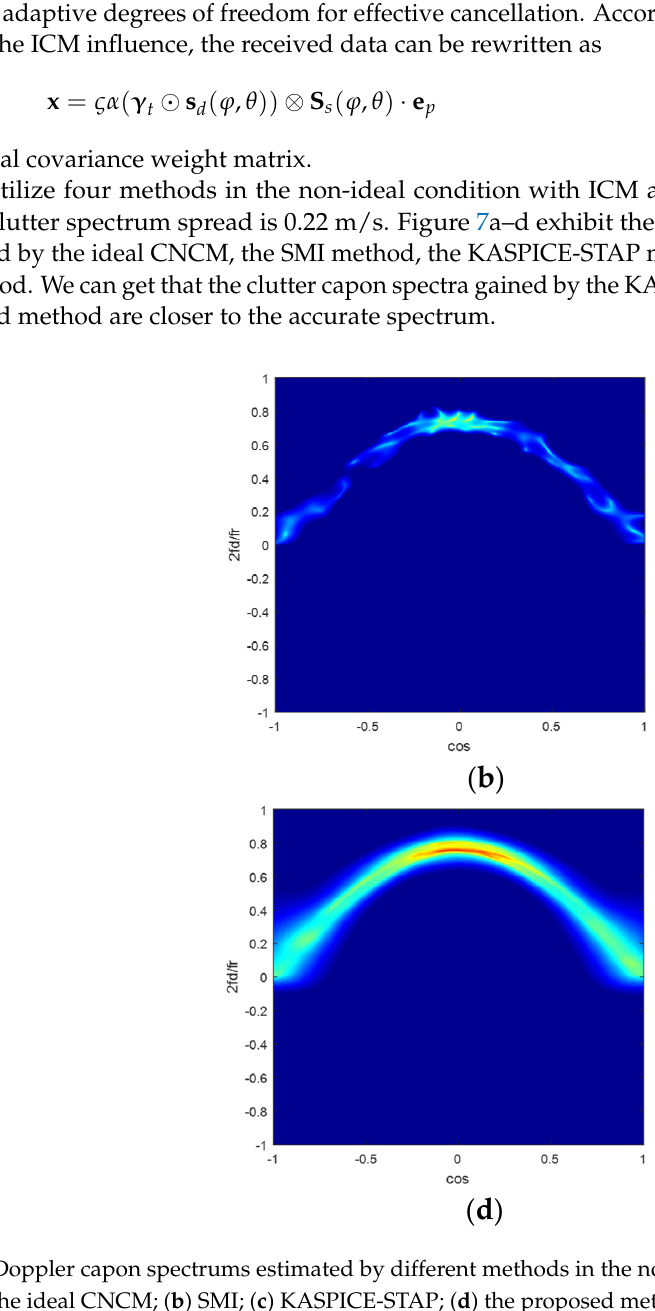
( b ) Figure 6. The IF versus normalized Doppler frequency with different methods ( a ) the model error